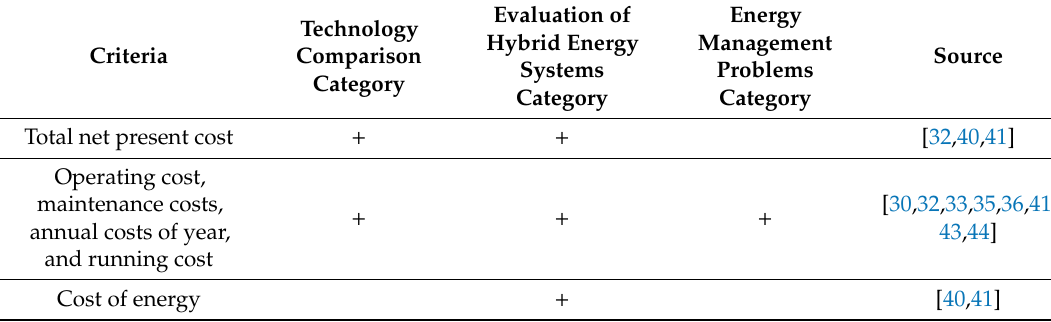
Table 5. The overview of economic